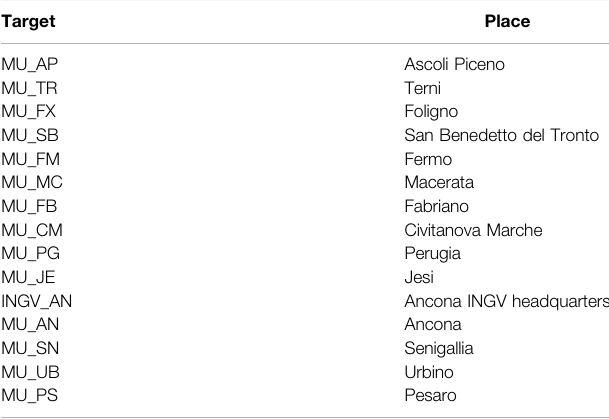
TABLE 1 | Target: city code. Place: extended name of cities. Target